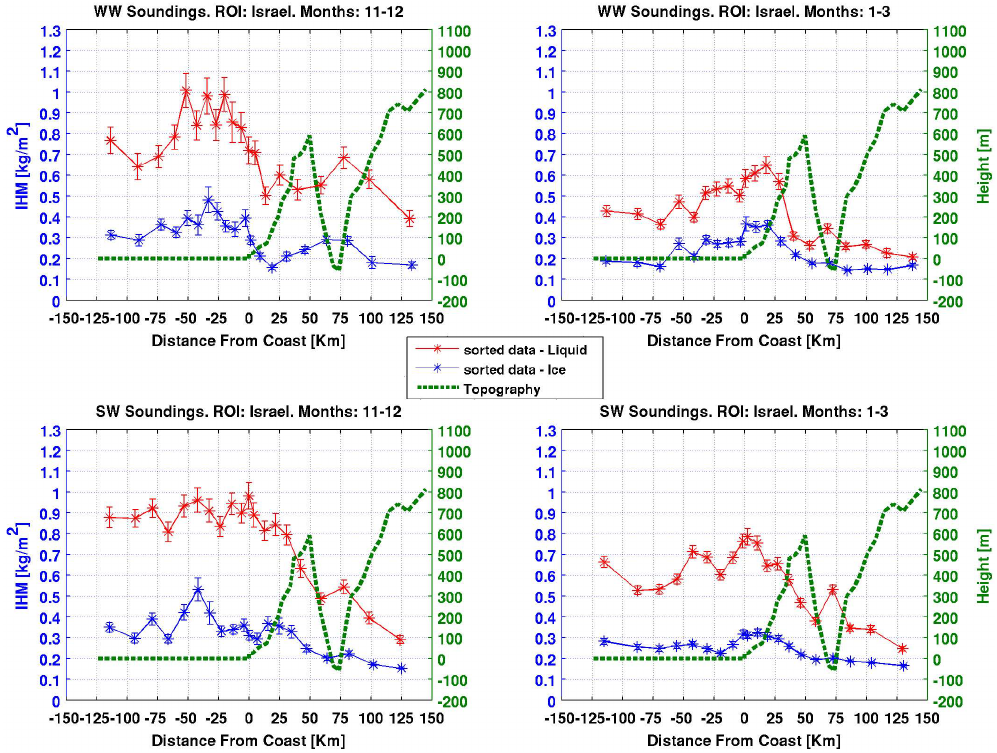
Fig. 7. Same as Fig. 6, but with data separated to WW (upper two figures) and SW events (lower two figures). Weak Wind (WW) events correspond to soundings with easterly and weak westerly low-level winds. Strong Wind (SW) events correspond to soundings with moderate to strong westerly low-level winds. For WW events, the November–December, January–March counts per bin are 362, 663 for liquid IHM and 319, 638 for ice IHM, respectively. For SW events, the November–December, January–March counts per bin are 813, 1314 for liquid IHM and 683, 1239 for ice IHM,